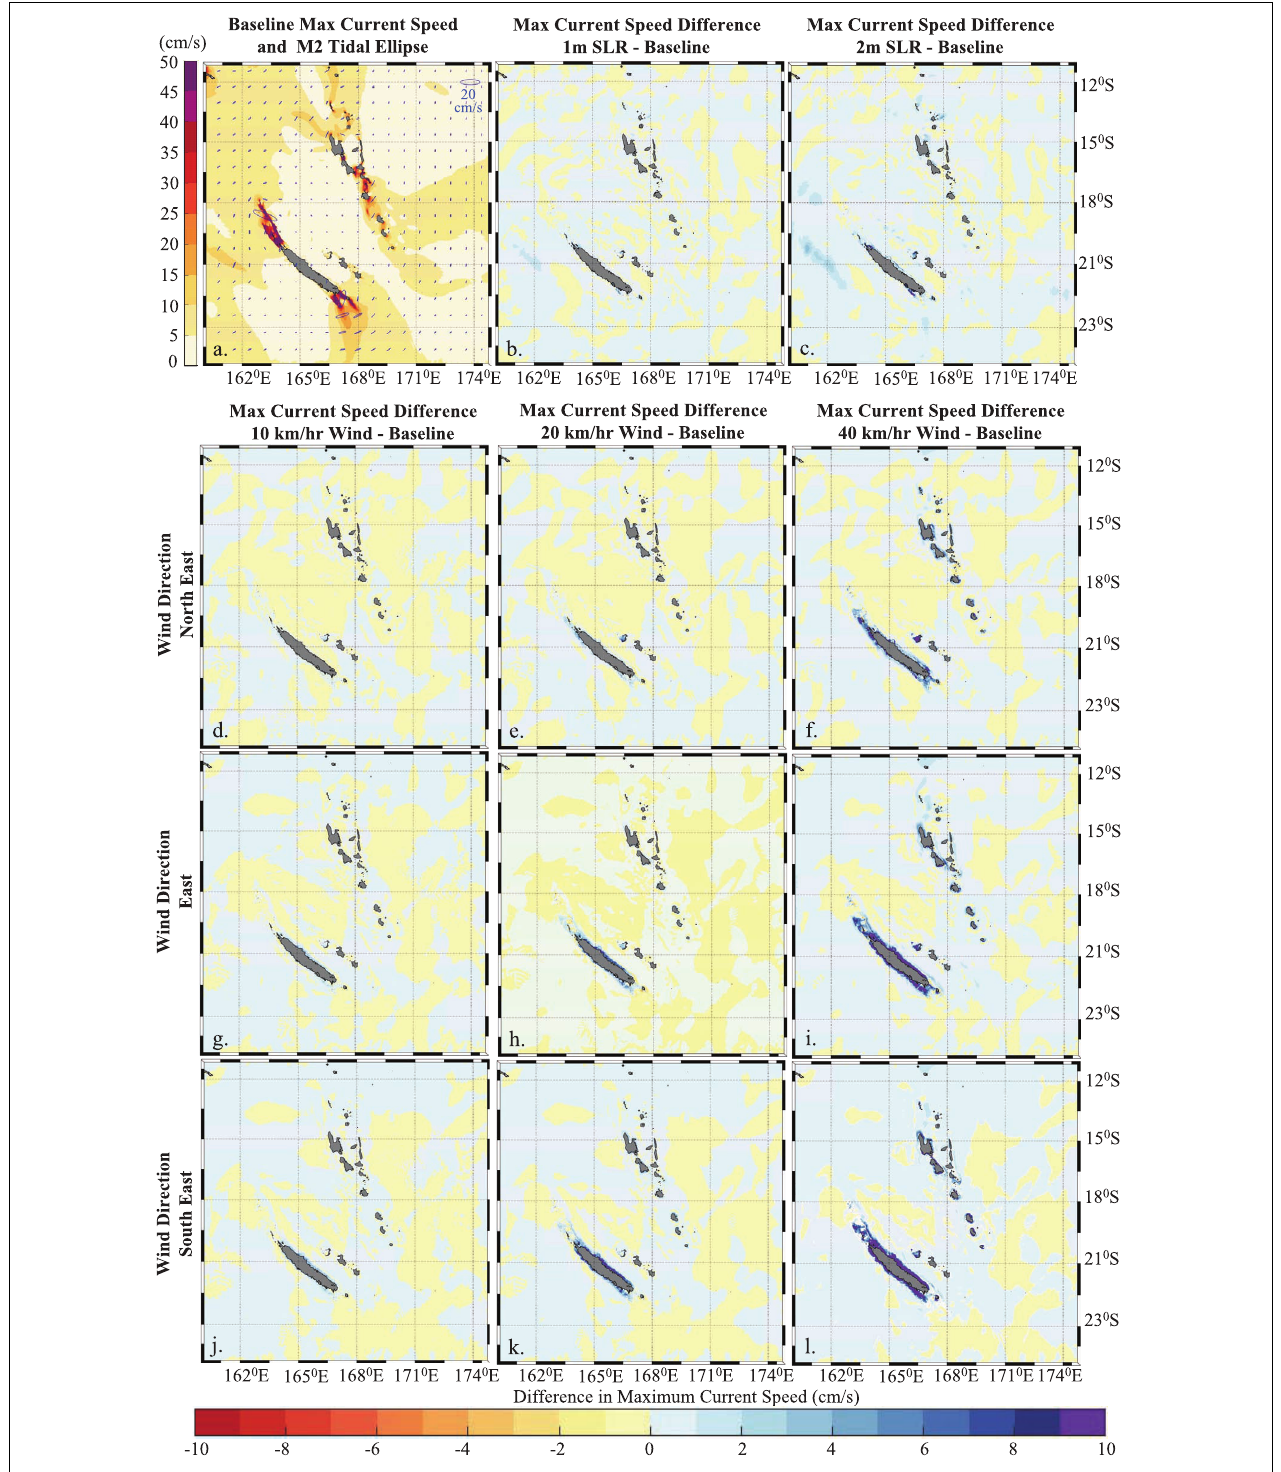
FIGURE 3 | Baseline maximum depth-averaged current speeds (cm/s) across the whole model domain shown underlying M2 tidal ellipses (a) . Change in maximum depth-averaged current speeds (cm/s) under 1 m SLR (b) and 2 m SLR (c) . Change in maximum depth-averaged current speed (cm/s) under 10 km/h (d) , 20 km/h (e) , and 40 km/h (f) northeast winds. Change in maximum depth-averaged current speed (cm/s) under 10 km/h (g) , 20 km/h (h) , and 40 km/h (i) east winds. Change in maximum depth-averaged current speed (cm/s) under 10 km/h (j) , 20 km/h (k) , and 40 km/h (l) southeast winds. Latitudes are displayed to the right of panels (c,f,i,l) . Longitude for all panels are displayed below panels (j–l)